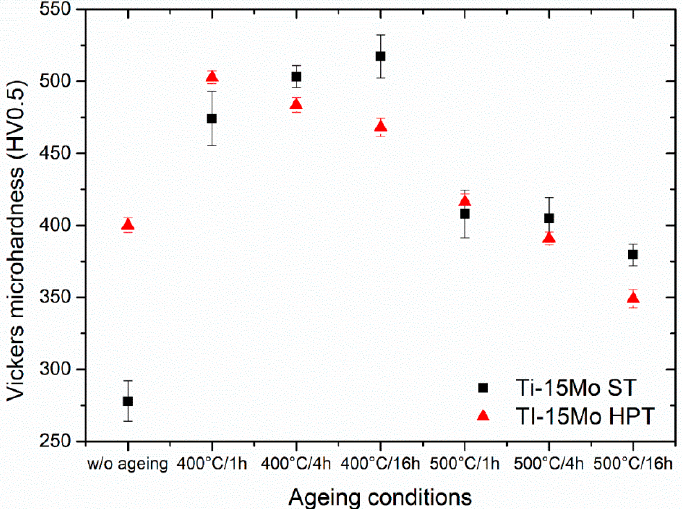
Figure 10. The evolution of the microhardness during ageing in the non-deformed and HPT- deformed